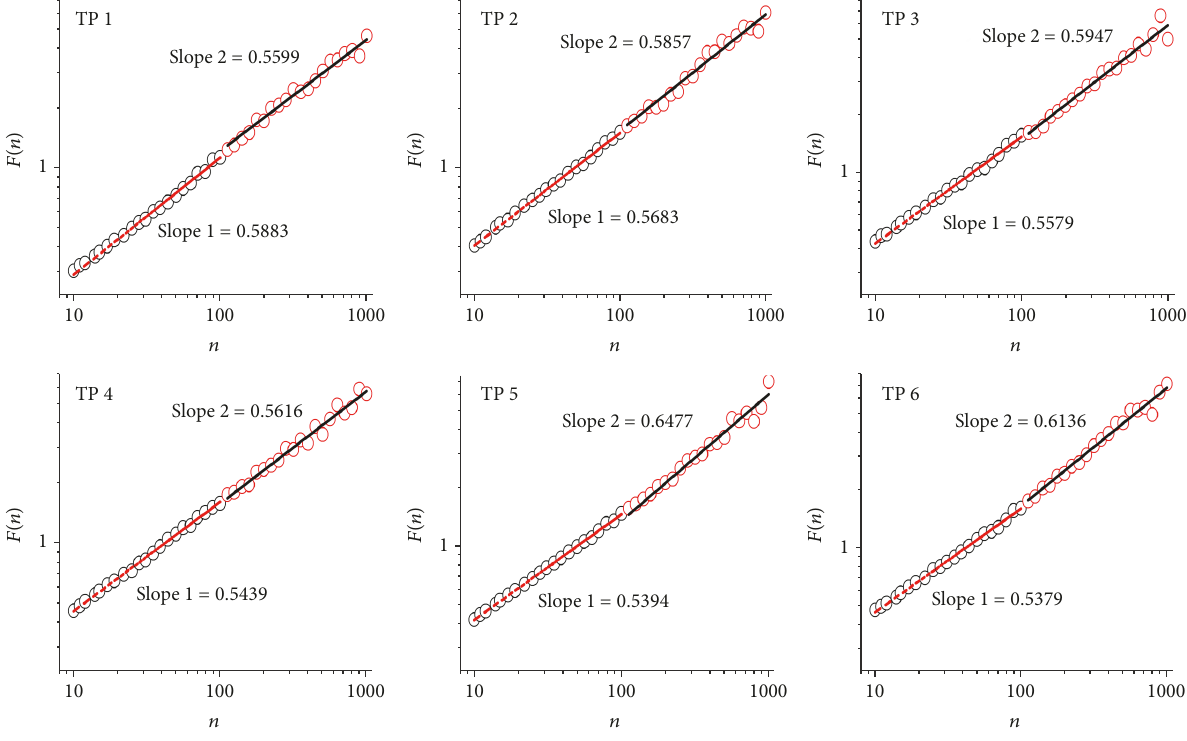
Figure 6: DFA analyses of Chinese word length sequence across six time periods.